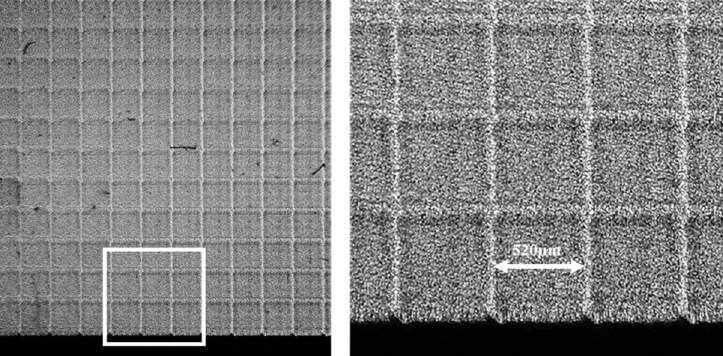
Figure 21. Magnified image of a 60 × 60 Hogel array forming an off-axis holographic lens. The camera system was focused on the vHOE plane and the Hogels are reconstructed “On Bragg” with the reconstruction beam [57].